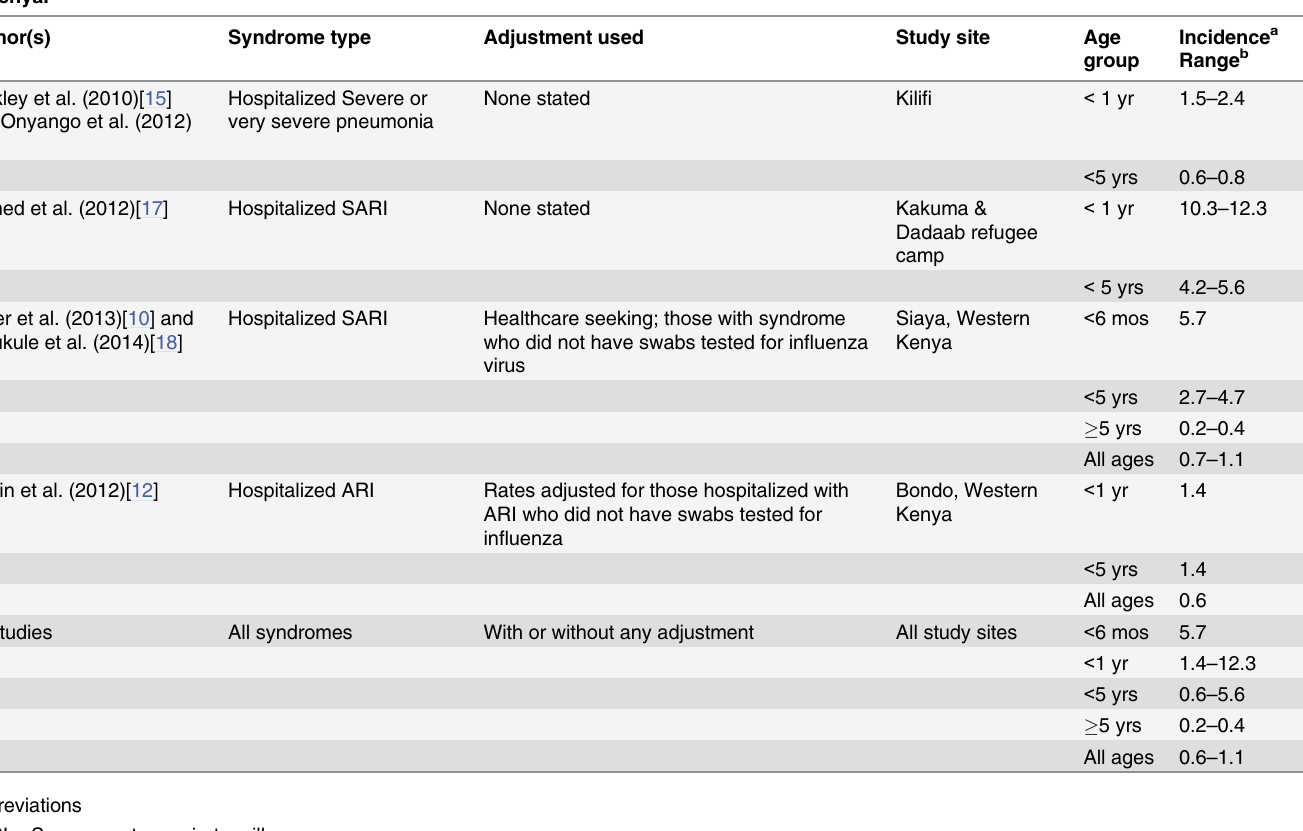
Table 1. Average annual incidence rates of hospitalization with influenza for different respiratory syndromes (per 1,000 persons or person-years) in